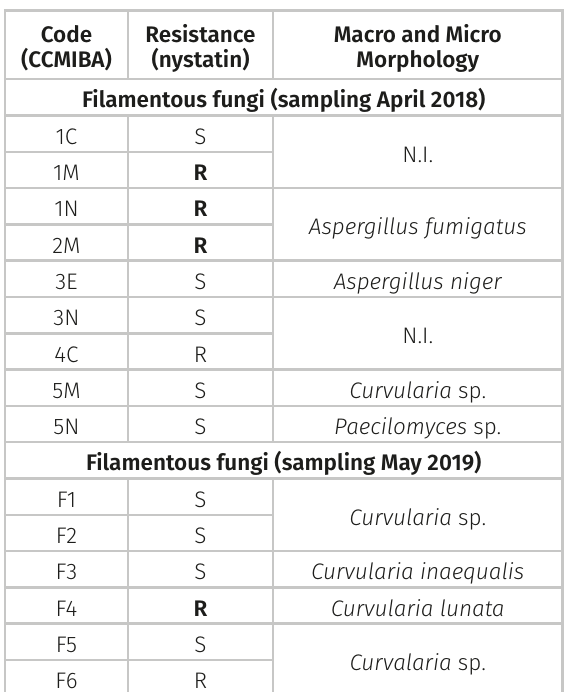
Table II. Fungi strains isolated from leachate and resistant potential to